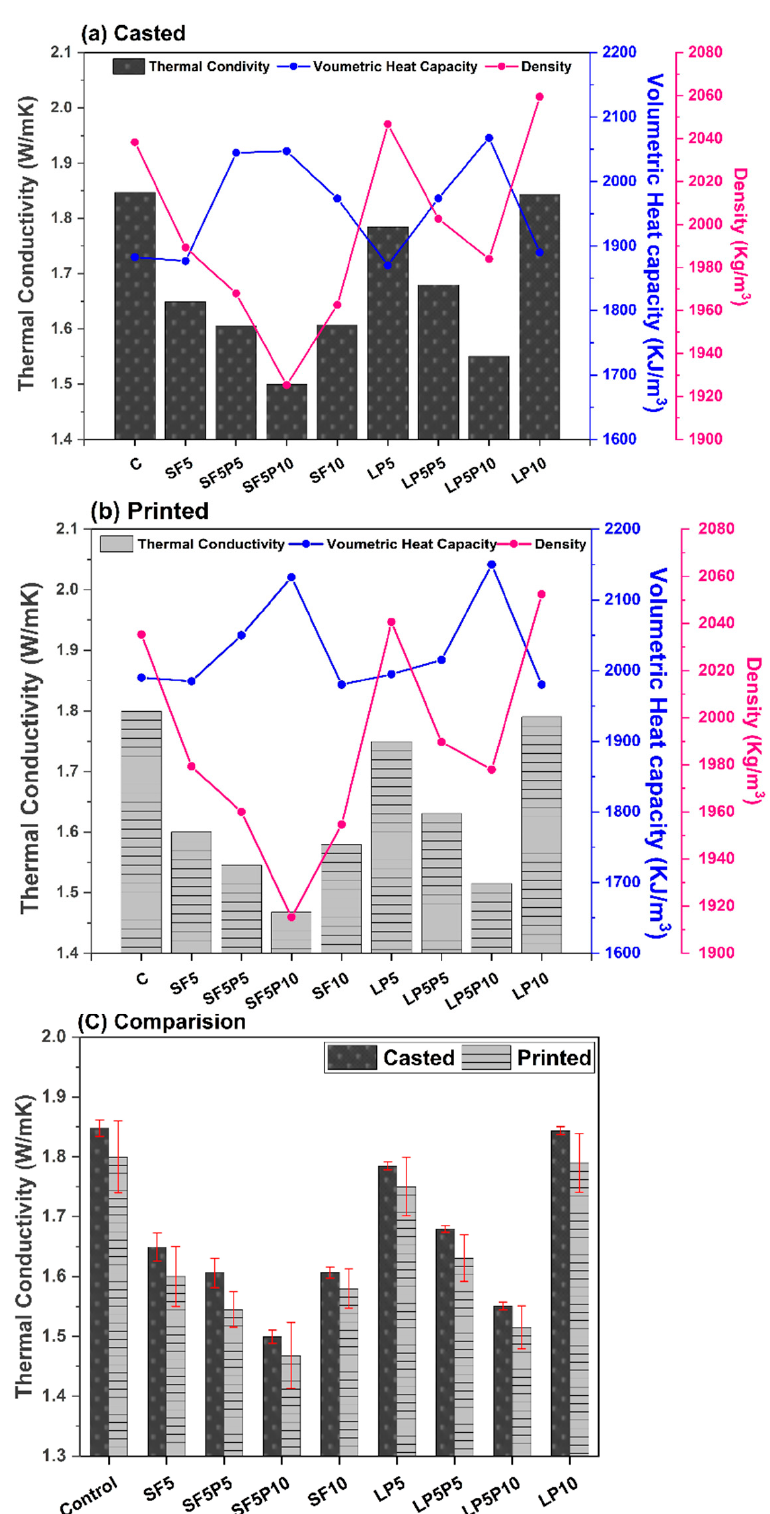
Figure 10. Thermal conductivity, volumetric heat capacity and density of ( a ) casted, ( b ) 3D printed specimens, and ( c ) their comparative analysis.